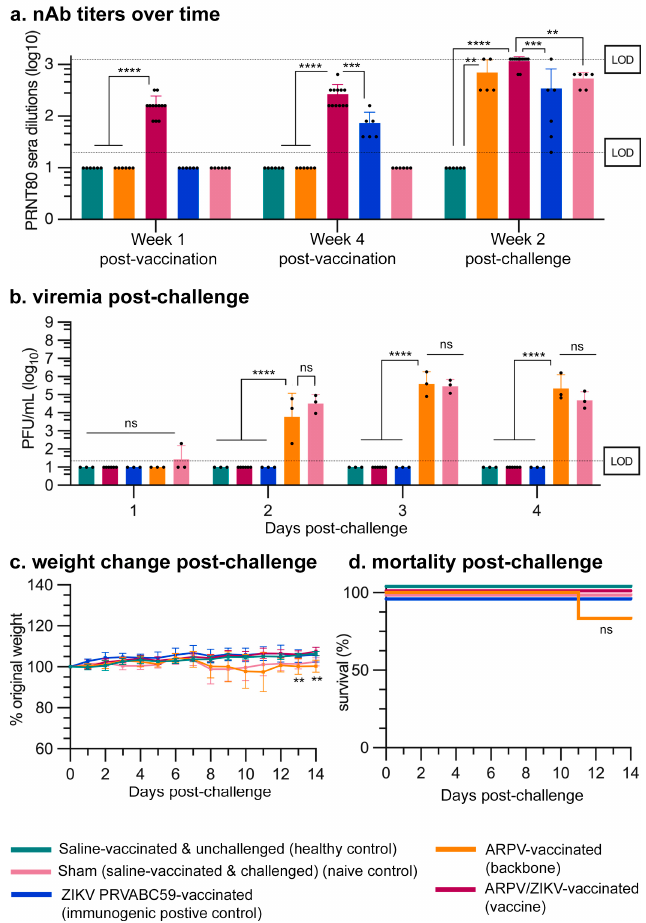
Figure 5. Single-dose ARPV/ZIKV vaccination provided complete protection against ZIKV challenge in C57BL/6 mice. Four-week old C57BL/6 mice (n = 12 for ARPV/ZIKV; n = 6 for all other groups) were immunized at day 0 post-vaccination. Vaccination with mouse-attenuated ZIKV PRVABC59 served as an immunogenic positive control. Mice were administered a WT ZIKV challenge 30 days post-vaccination (dpv), except for healthy control mice, which were injected with saline at challenge. Type I IFN (IFN- α / β ) was transiently inhibited using a MAR1-5A3 in vivo antibody blockade prior to ZIKV challenge. ( a ) ZIKV-specific nAb titers measured by PRNT 7 days post-vaccination (dpv), 28 dpv and 14 days post-challenge (dpc). Values represent the reciprocal of the highest serum dilution able to reduce ZIKV plaque formation by 80%. Dotted lines represent the 20-fold or 1280-fold dilution limits of detection (LOD). ( b – d ) ARPV/ZIKV-vaccinated mice were completely protected from morbidity and mortality post-challenge. ( b ) Viremia was measured 1–4 dpc by plaque assay. LOD is 100 PFU/mL. ( c ) Weight change of mice post-challenge. ARPV-vaccinated mice differed from healthy controls on 13–14 dpc by p ≤ 0.002. ( d ) Kaplan–Meier survival plot of mice post-challenge. ( a , b ) Columns indicate mean values and error bars indicate SD of the mean. Circles represent individual mouse data points. ( c ) Data points represent mean values. Error bars indicate SD of the mean. Significance was determined by one-way ANOVA ( a , c ), two-way ANOVA ( b ), or log-rank (Mantel–Cox) test ( d ). Unless otherwise marked, asterisks indicate significance compared to healthy controls: not significant (ns), p ≤ 0.002 (**), p ≤ 0.0002 (***) and p ≤ 0.0001 (****).